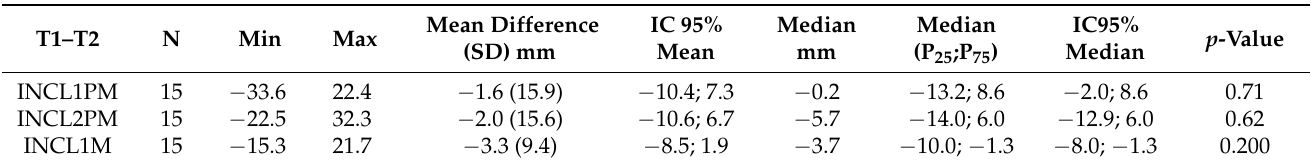
Table 8. Comparison of Pre and Post treatment Dental inclination measurements. Dental inclination changes after maxillary expansion comparing CbctT1-CbctT2 measurements. INCL: inclination. 1PM: first premolar; 2PM: second premolar and M1: first